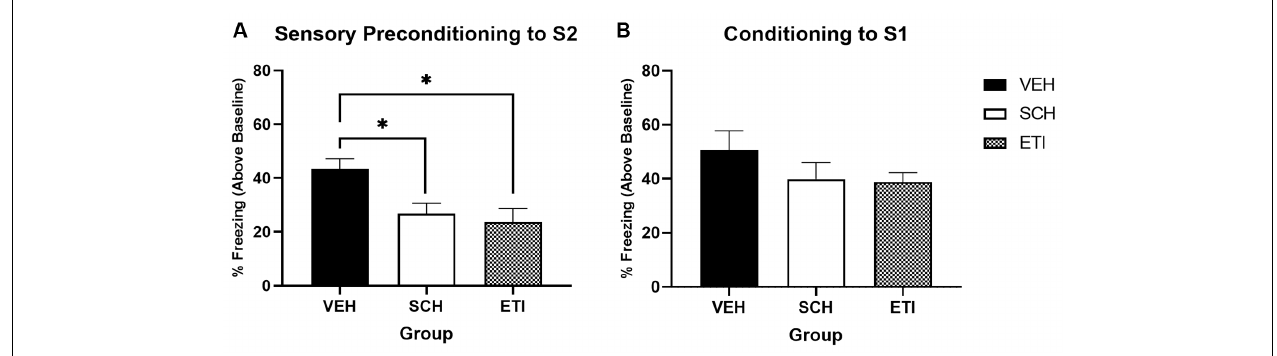
FIGURE 4 | Sensory preconditioning under conditions of dopamine receptor antagonism when trained in an appetitive context. Panel (A) shows the average per cent time spent freezing in response to S2 (stimulus—baseline) on the test of sensory preconditioning. Freezing was significantly higher in vehicle-treated rats (VEH; n = 11) compared to either SCH39166- (SCH; n = 12) or eticlopride-treated rats (ETI; n = 12). Panel (B) shows the average per cent time spent freezing to S1 (stimulus—baseline) on the test of first-order conditioning. Black bars indicate treatment with saline vehicle, white bars indicate treatment with (mid-dose) D1R antagonist SCH39166, and grey hashed bars indicate treatment with (mid-dose) D2R antagonist eticlopride. Error bars represent ± SEM. Significant comparisons are indicated by: ∗ where p <